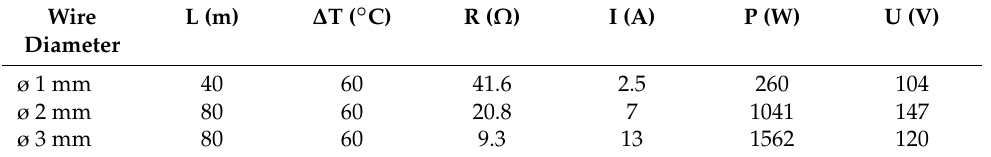
Table 3. Parameters required for performing the SMA wire heating tests with direct current. Wire